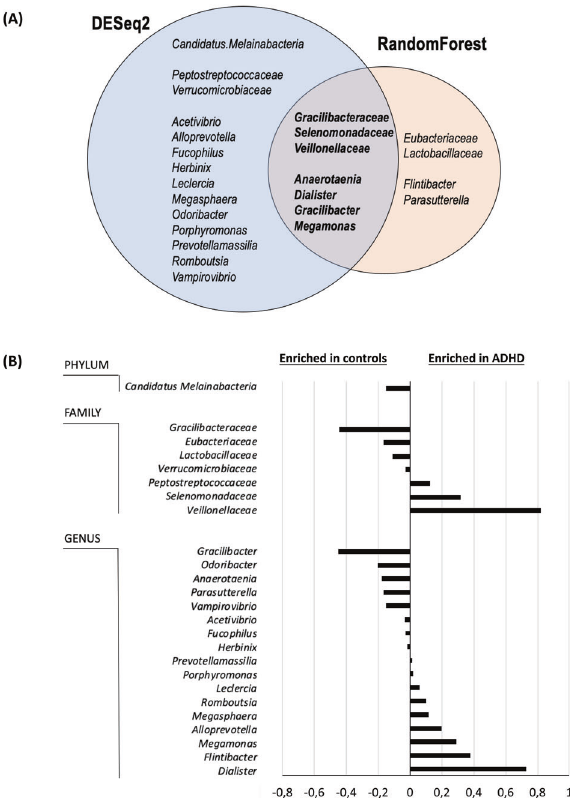
Fig. 1 Differentially abundant taxa between ADHD cases and controls. ( A ) Differential abundance results according to two different methods, DESeq2 andrandom forests. B Differences in relative abundance between ADHD cases and controls for taxo- nomic groups surpassing multiple comparison corrections in DeSeq2 and/or random forest